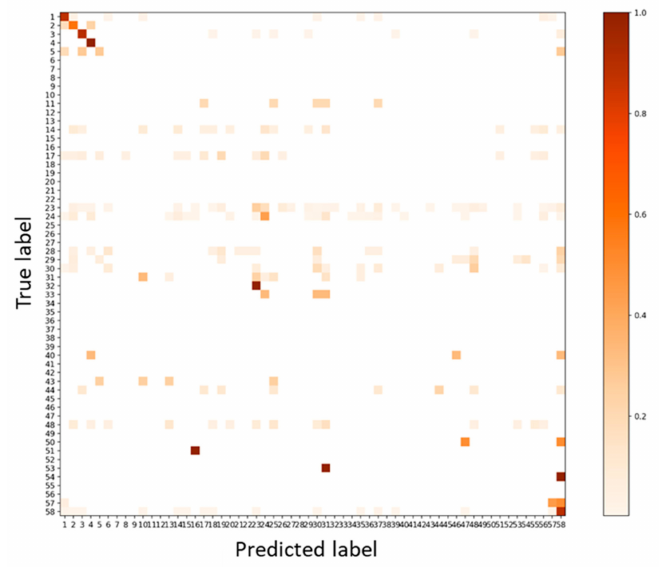
Figure 8. Classification result of the test. The vertical axis is the ground truth and the horizontal axis is the model prediction. The number in each cell indicates the number of classified images; each cell is colored according to the percentage of the number of images in each class. The Kappa score is